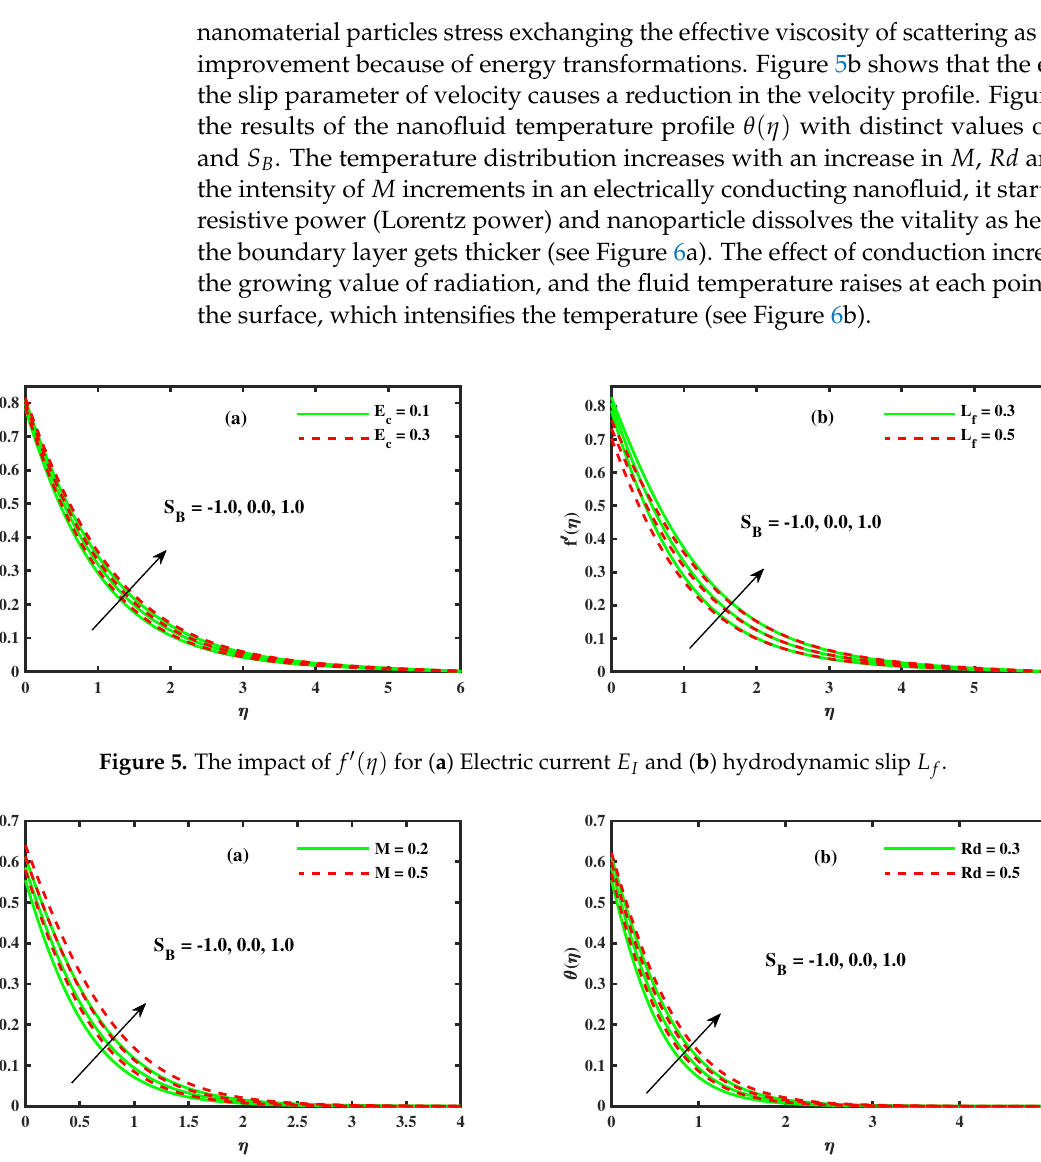
Figure 6. The impact of θ ( η ) for ( a ) Magnetic field M and ( b ) radiation Rd . Figure 7a,b represent the results of the nanofluid temperature profile with distinct values of the Eckert number Ec , thermal slip parameter L θ , and Stefan blowing parameter S B . The impact of the Eckert number is exposed in Figure 7a. The Eckert number effects include expanding the temperature due to frictional heating. Normally, the heat transfer ascends in the manners of electronic chips, power generation systems, fluid metal liquids, just as cooling of nuclear reactors. The ratio between the flow kinetic energy and enthalpy of the boundary layer difference is called the Eckert number. Physically, the temperature can be increased due to the multiplication of the Joule heating effect from the product of the magnetic and Eckert number. Figure 7b uncovers the physical attributes of the thermal slip boundary L θ on θ ( η ) . The impact is identical to the velocity profile (see Figure 5b). Basically, the temperature is represented by a nonlinear connection between the foothold and slip in the polymer dissolve. The temperature decreases radically under permeable circumstances. Figure 8a,b present the behavior of the nanofluid temperature profile with different values of the unsteady parameter σ t and thermal buoyancy λ . The impact of unsteadiness σ t on the dimensionless temperature distribution θ ( η ) (see Figure 8a) is identical to the effect of the velocity profile (see Figure 4b). The performance of the